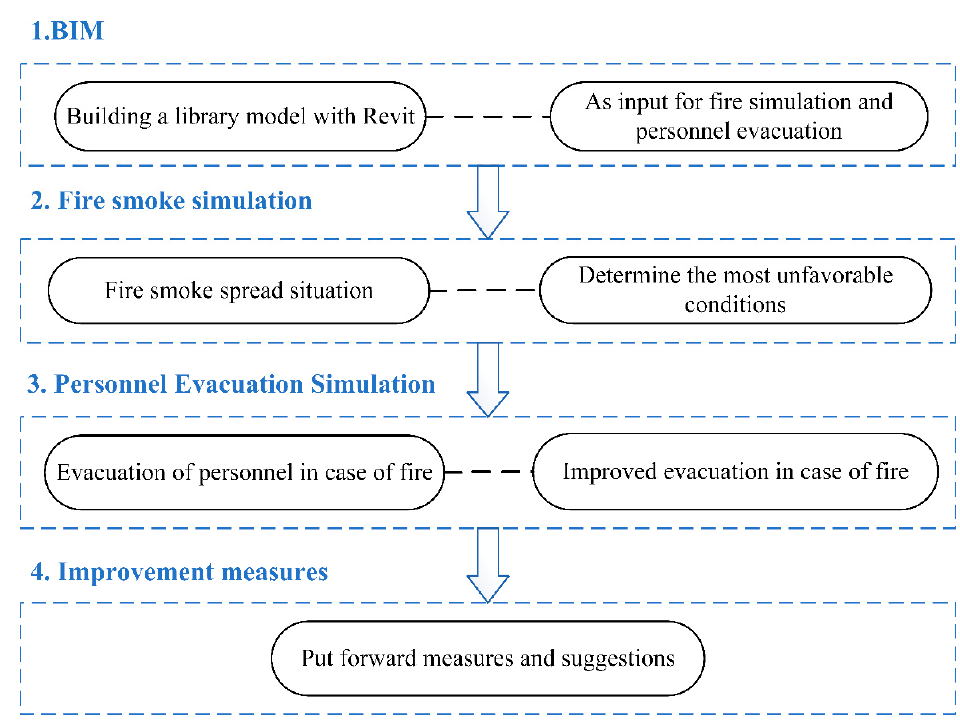
Figure 4. Research roadmap.